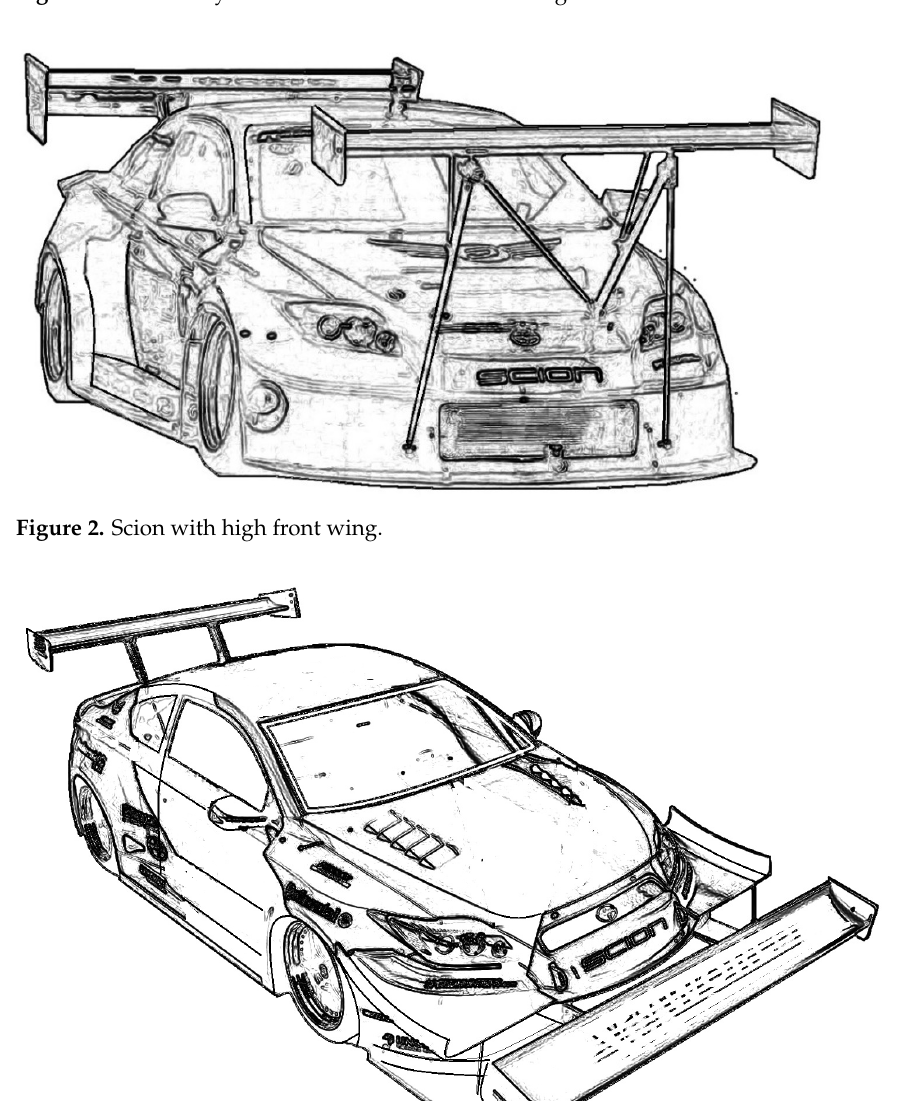
Figure 1. Electric Toyota TMG-EV-P002 with front wing.